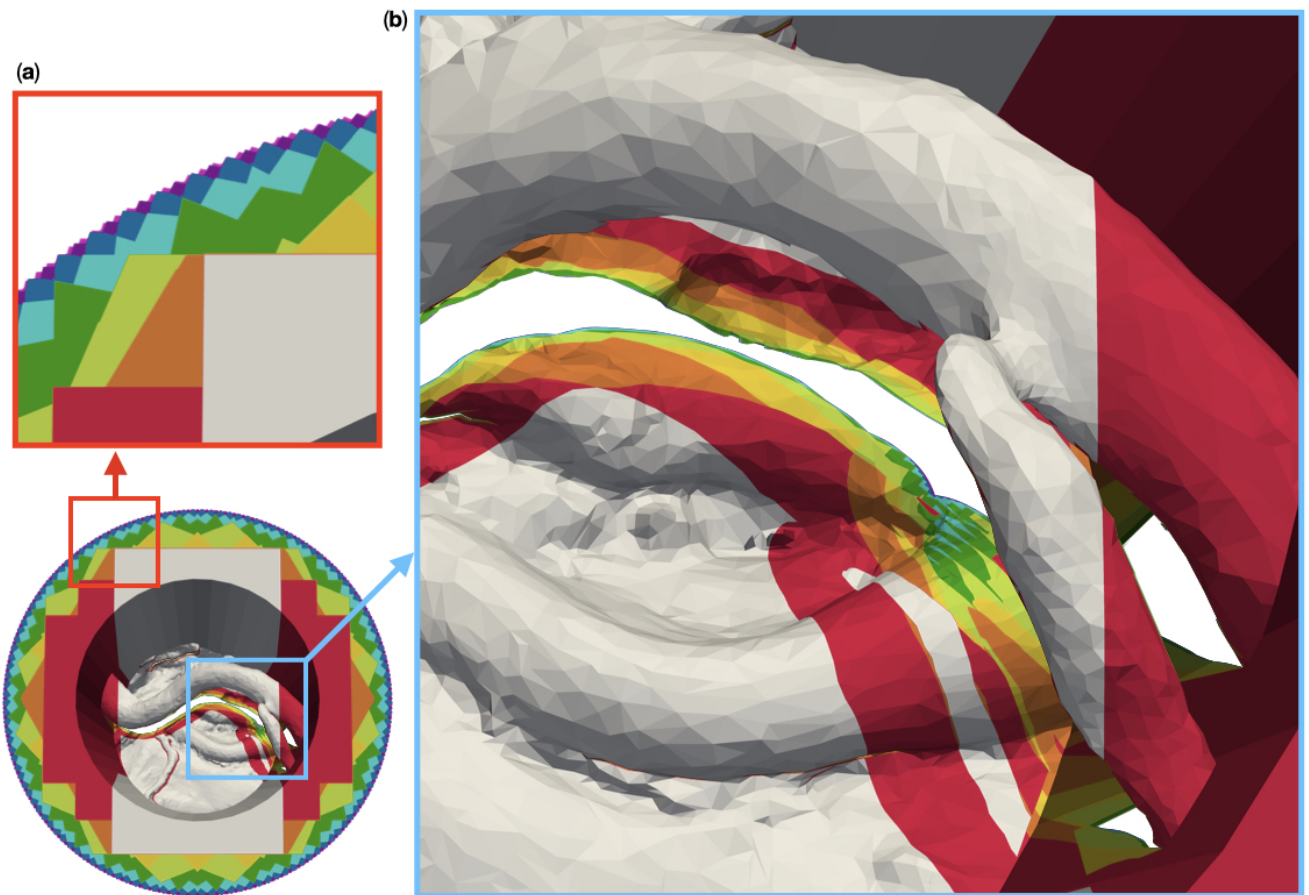
Figure 9. Magnified images of the 3D reconstructable surface of the model “circ artery”. The reconstruction with the largest area was placed in the background and the reconstruction with the smallest area in the foreground. ( a ) shows that the reconstructable area towards the outside of the top surface increases noticeably up to 128 cameras. After that, the increase is difficult to visually. ( b ) shows part of the model in which a vessel with a branch obscures the anatomy below. Large portions of this area are not reconstructable with two cameras (gray). In contrast to this, with four cameras, the red portions become available. The areas in different colors represents additional areas reconstructable with six (orange), eight (yellow), 16 (lime), 32 (green), 64 (cyan), 128 (blue), 256 (purple), and 360 (magenta)